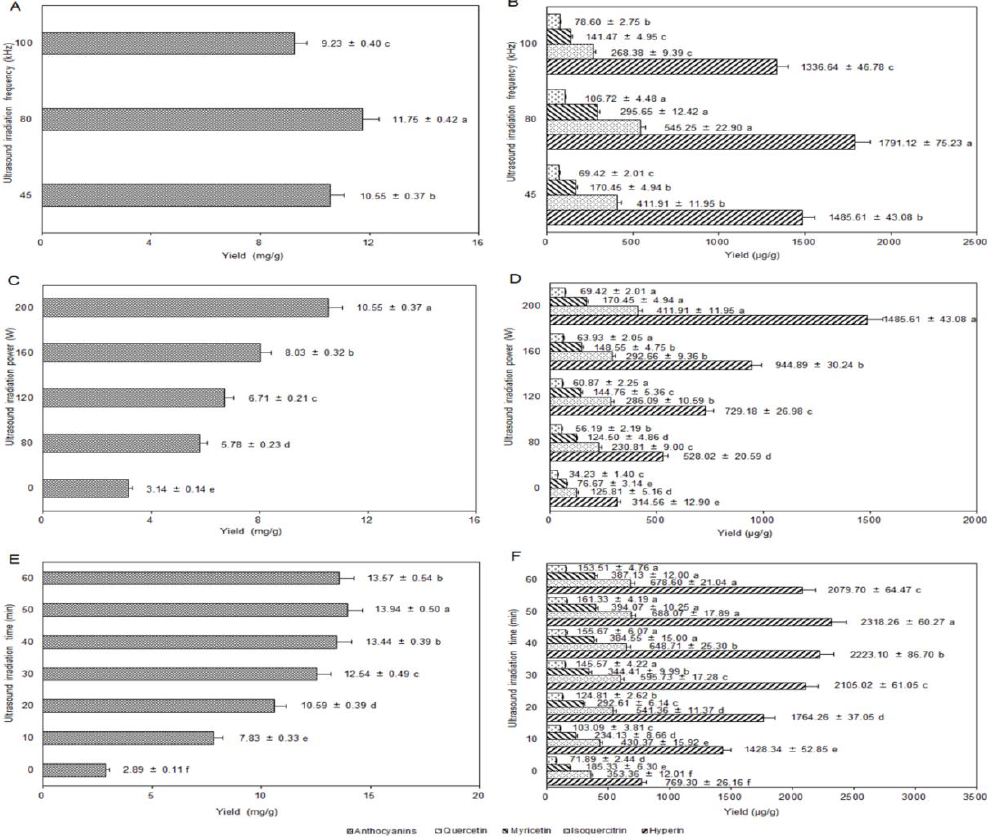
Figure 4. Influence of ultrasound irradiation frequency on the extraction yields of anthocyanins ( A ) and flavonols ( B ); influence of ultrasound irradiation power on the extraction yields of anthocyanins ( C ) and flavonols ( D ); influence of ultrasound irradiation time on extraction yields of anthocyanins ( E ) and flavonols ( F ).